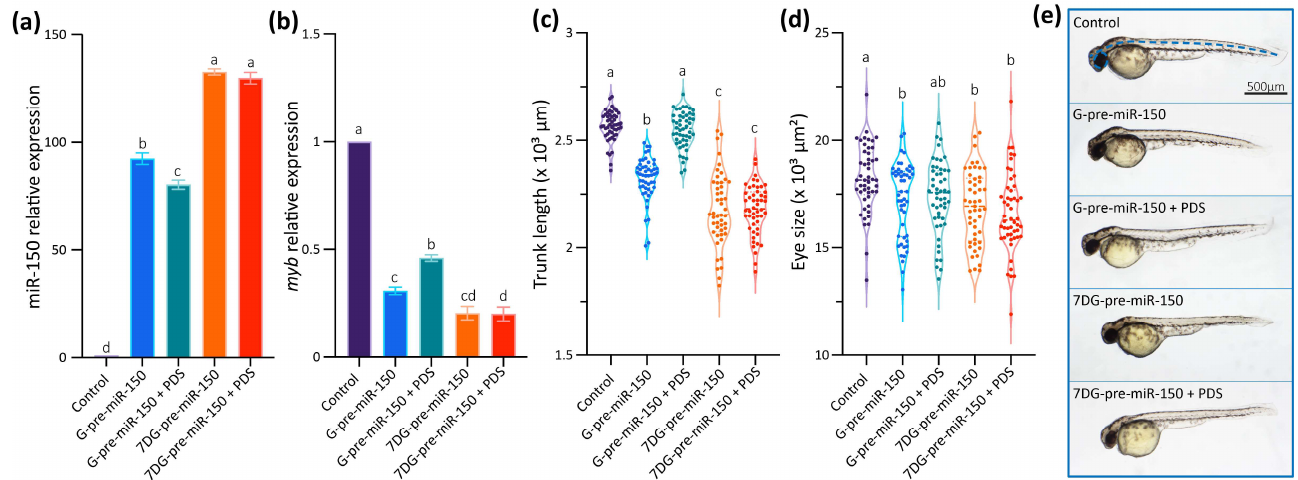
Figure 5. In vivo effect of PDS on pre-miR-150 G4 during zebrafish embryo development. RT-qPCR quantification of miR-150 ( a ) and myb ( b ) of 24 hpf staged embryos microinjected with G- or 7DG- miR-150 in the absence or in the presence of 5 µM PDS. Ordinary 1-way ANOVA with Tukey multiple comparisons test, p < 0.001. Trunk length ( c ) and eye size ( d ) measurements of microinjected 48 hpf staged larvae microinjected with G- or 7DG-miR-150 in the absence or in the presence of 5 µM PDS. Ordinary 1-way ANOVA with Tukey multiple comparisons test, p < 0.001. Letters above each condition in the graphs represent statistical groups, where means with no letter in common are significantly different. For graphs shown in ( a – d ), p -values are detailed in Supplementary Table S7 and numerical values are detailed in Supplementary Table S8. ( e ) Micrographs of representative 48 hpf staged larvae (lateral view, head to the left) microinjected with the RNA transcribed from pSP64T+dsRED plasmid containing no cloned pre-miRNA (control), G-pre-miR-150, G-pre-miR-150 + PDS, 7DG-pre-miR-150, and 7DG-pre-miR-150 + PDS. The measured parameters for graphs in Figure 5c,d are indicated by blue, dashed lines in the control. Data shown represent results of one from three independent experiments.